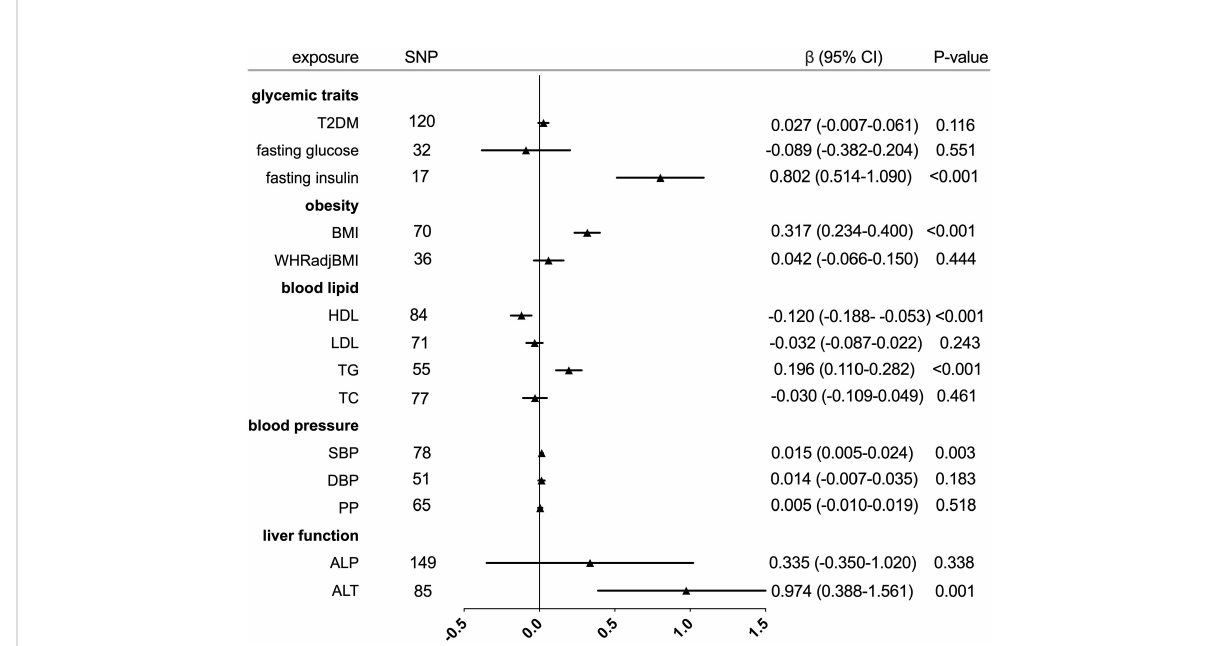
FIGURE 1 Forest plot of Mendelian randomization analyses for the genetical associations of glycemic traits, obesity, blood lipid, blood pressure, and liver function with increased serum urate. CI, con fi dence interval; SNP, single-nucleotide polymorphism.